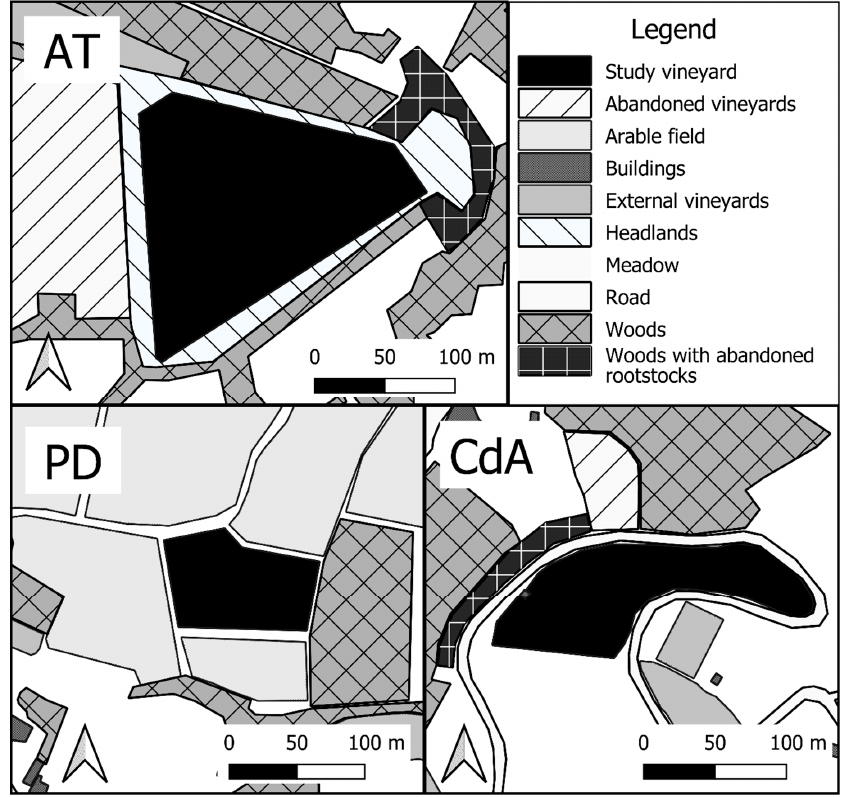
Figure 1. Vegetal composition of the surroundings of the three surveyed vineyards: AT: Asti; CdA: Cisterna d’Asti; PD: Paderna.